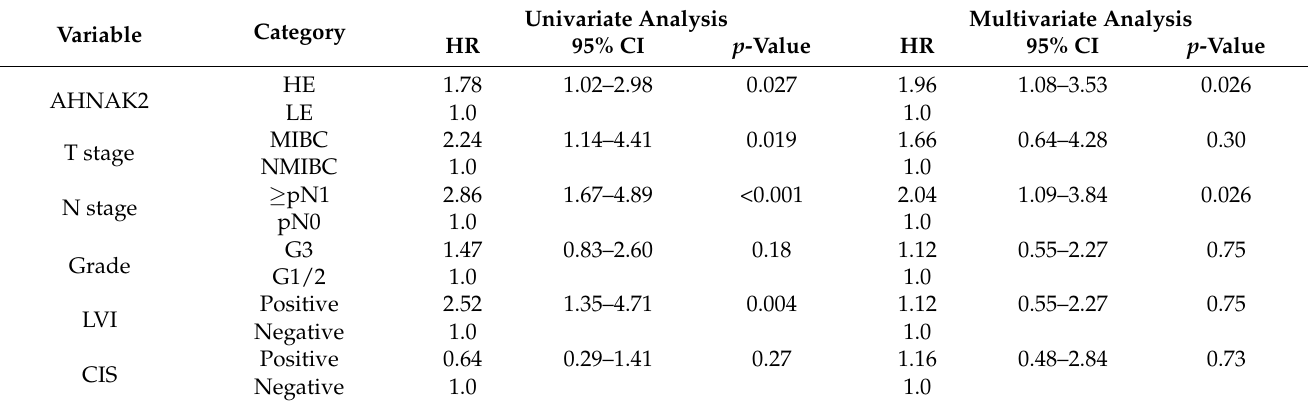
Table 2. Univariate and multivariate analyses for worse recurrence-free survival. AHNAK2, T stage, N stage, grade, lym- phovascular invasion (LVI), and carcinoma in situ (CIS) were evaluated, and statistically significant values are highlighted in